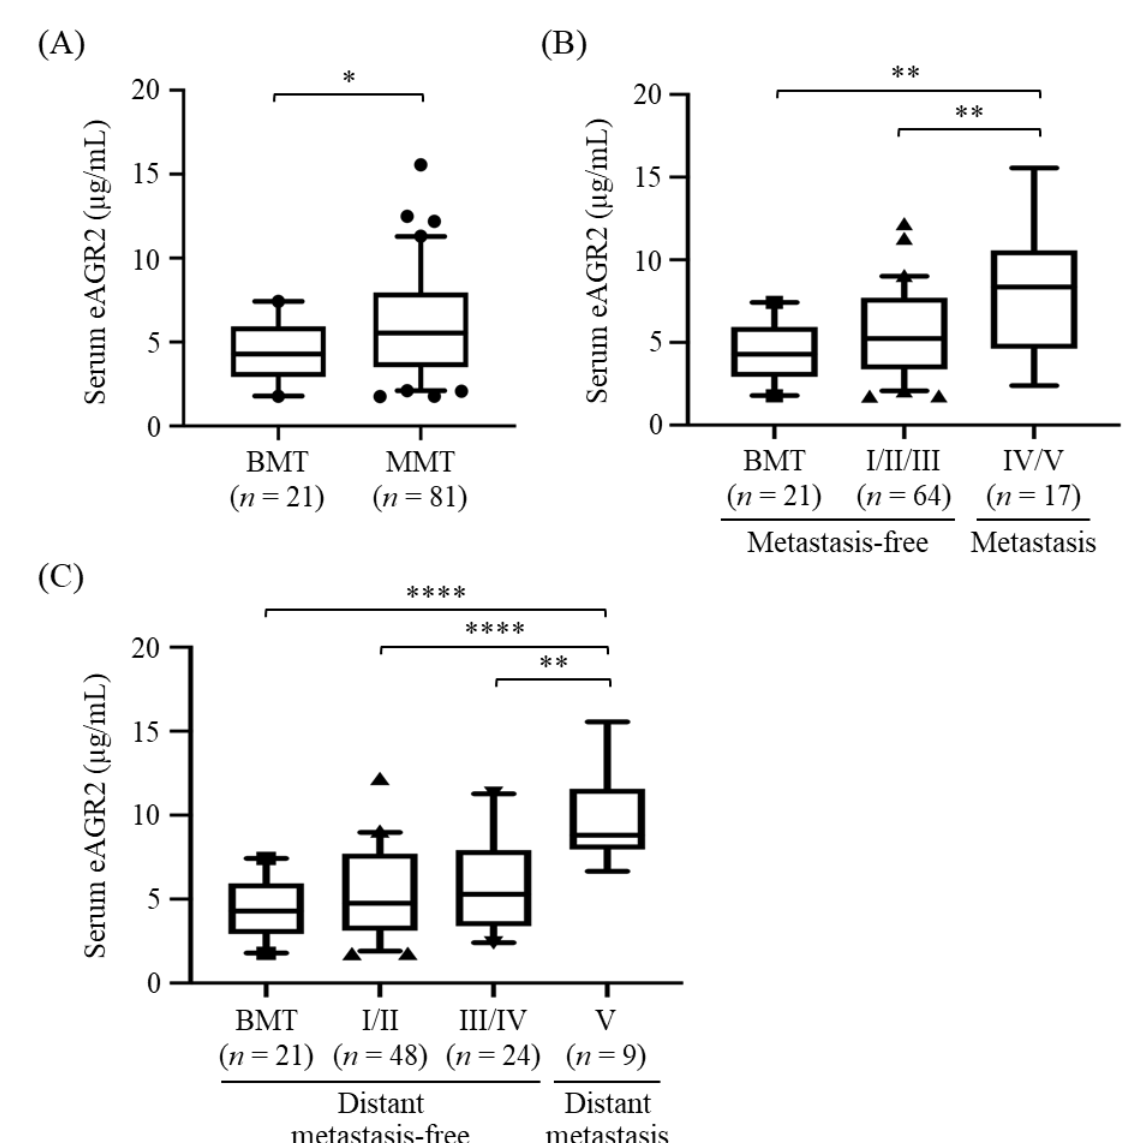
Figure 5. Elevated serum levels of eAGR2 in MMT dogs. Serum eAGR2 concentrations were compared between ( A ) BMT and MMT cases, ( B ) MMT with metastasis (stage IV/V) and metastasis-free cases (stage I to III), and ( C ) MMT with distant metastasis (stage V) and distant metastasis-free cases (stage I to IV). Results are presented in boxplots, wherein the median (bar), the 95th (upper whisker), and the fifth percentile (lower whisker) of the data are shown. Statistical significance between groups was determined by Mann–Whitney U test. * indicates p < 0.05, ** p < 0.01; **** p < 0.0001.